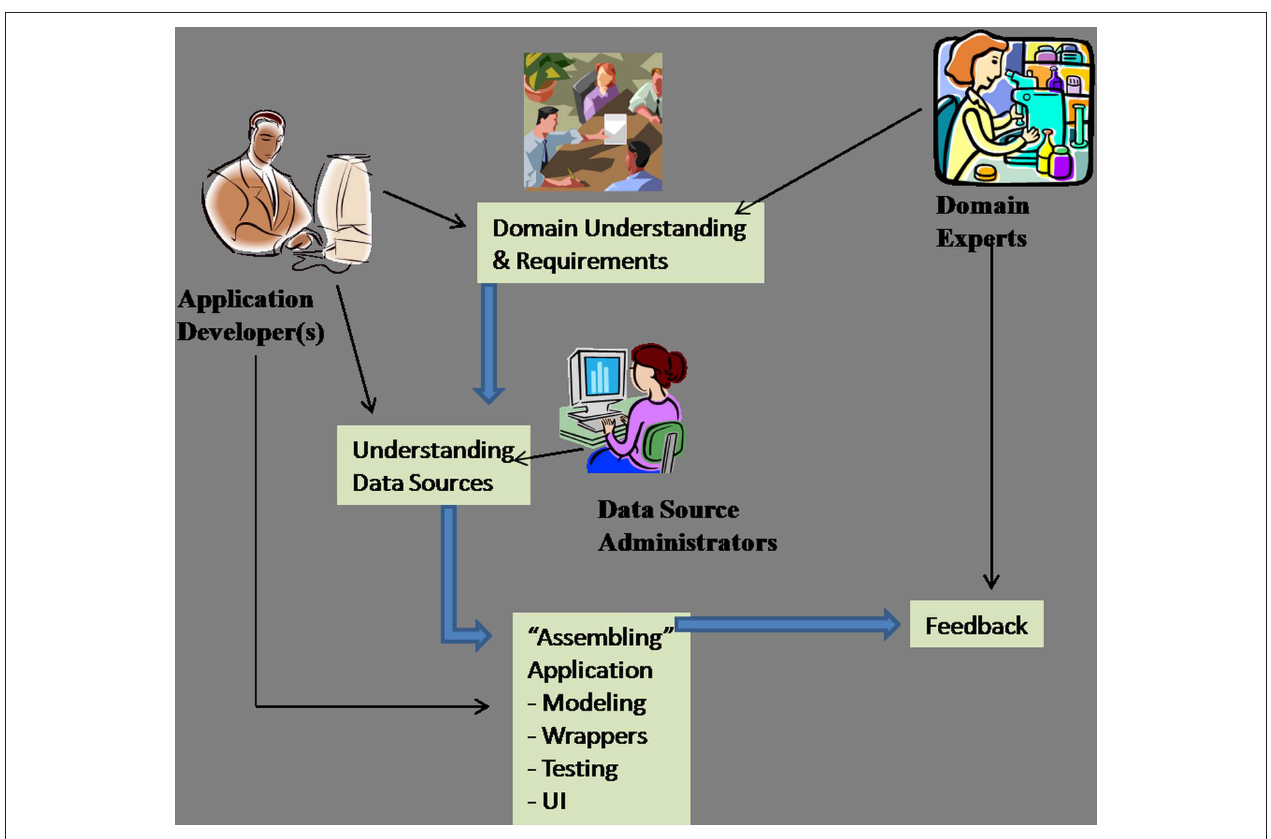
Figure 2 | Developing a data integration